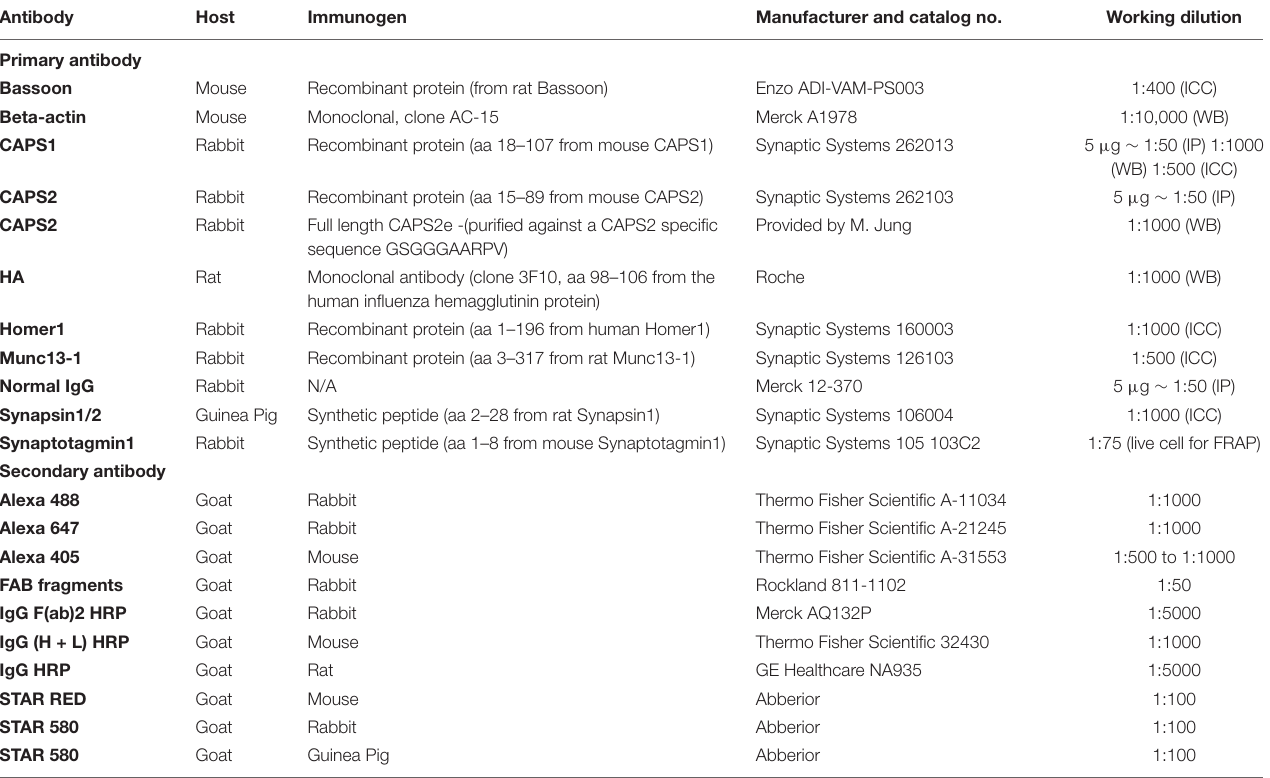
TABLE 1 | Details of antibodies used in this